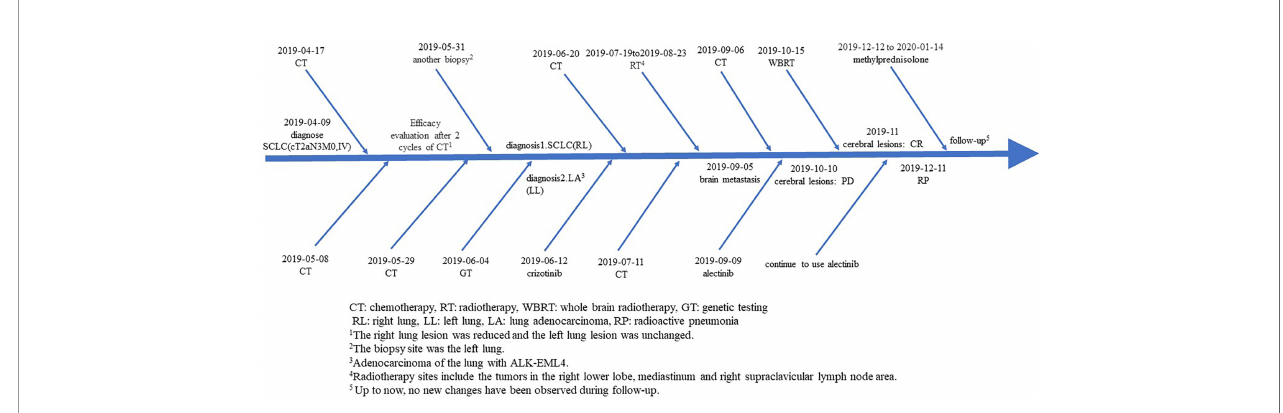
FIGURE 7 | Flow chart of patient